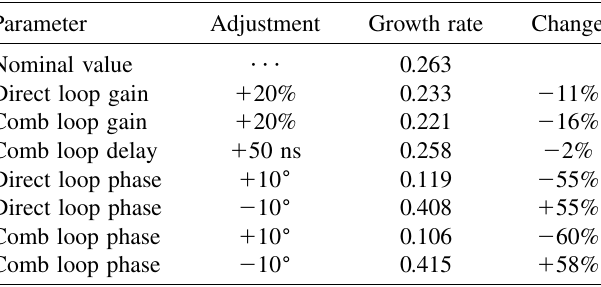
TABLE I. Growth rate sensitivity table.